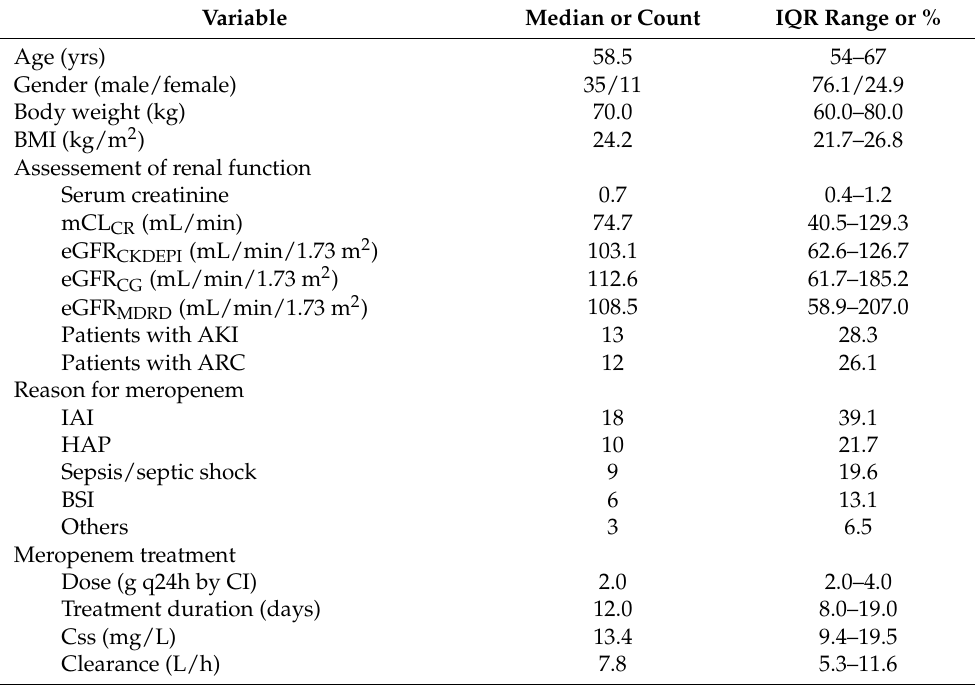
Table 1. Demographic and clinical characteristics of the population (n =